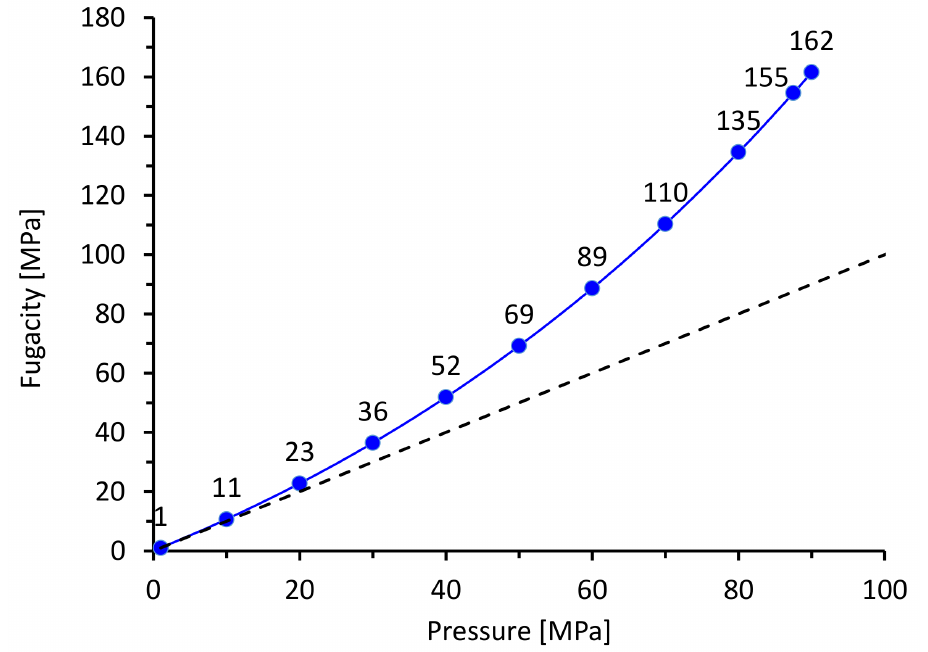
Figure 1. Correlation between pressure and fugacity at room temperature calculated by Equation (1). Error in Figure